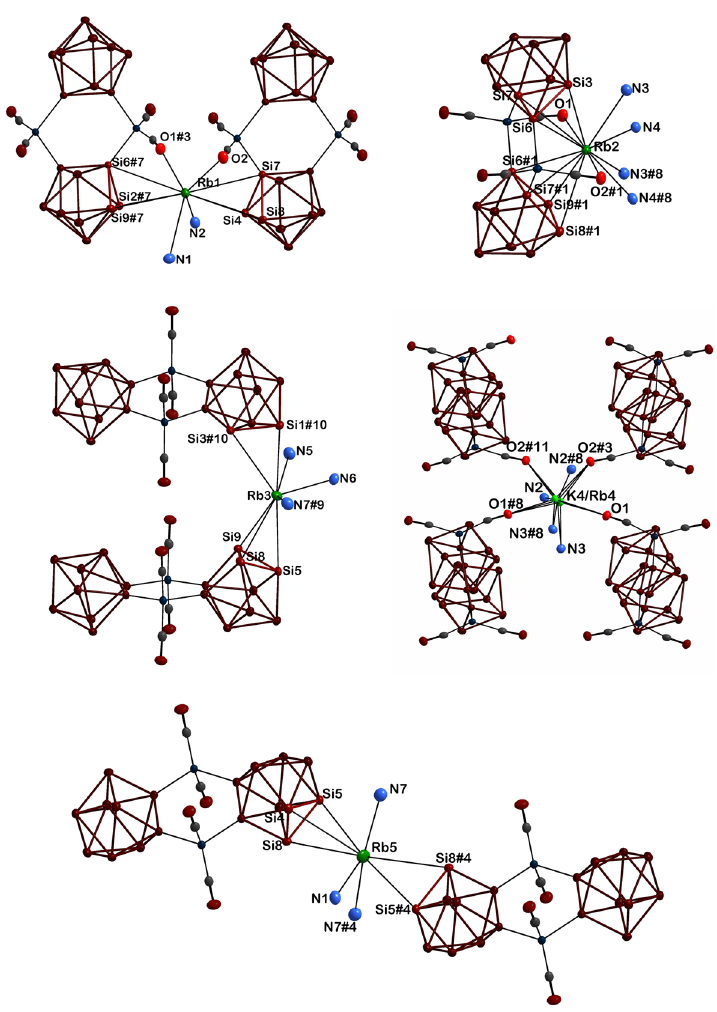
Figure 4. Coordination spheres of all five crystallographically independent cationic